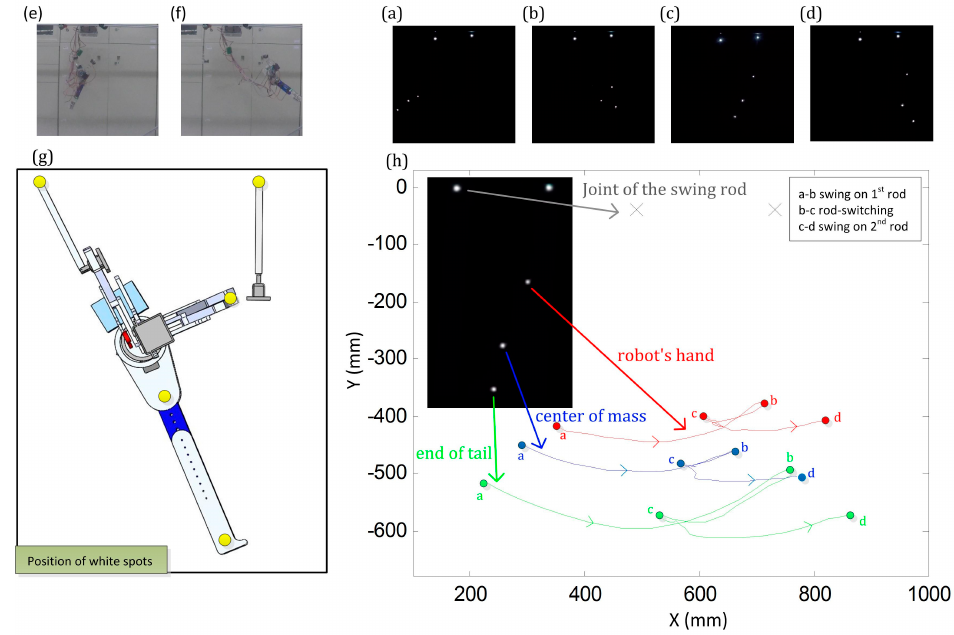
Figure 12. The MonkeyBot in brachiating motion. ( a – f ) The snapshots of the system captured by the camcorder before ( e , f ) and after ( a – d ) image processing; ( g ) The markers, whose locations are depicted in CAD drawing, were mounted on the MonkeyBot when it swung and switched rods; ( h ) The overall motion trajectories of the markers/system. The instants marked with a-d correspond with the snapshots ( a – d